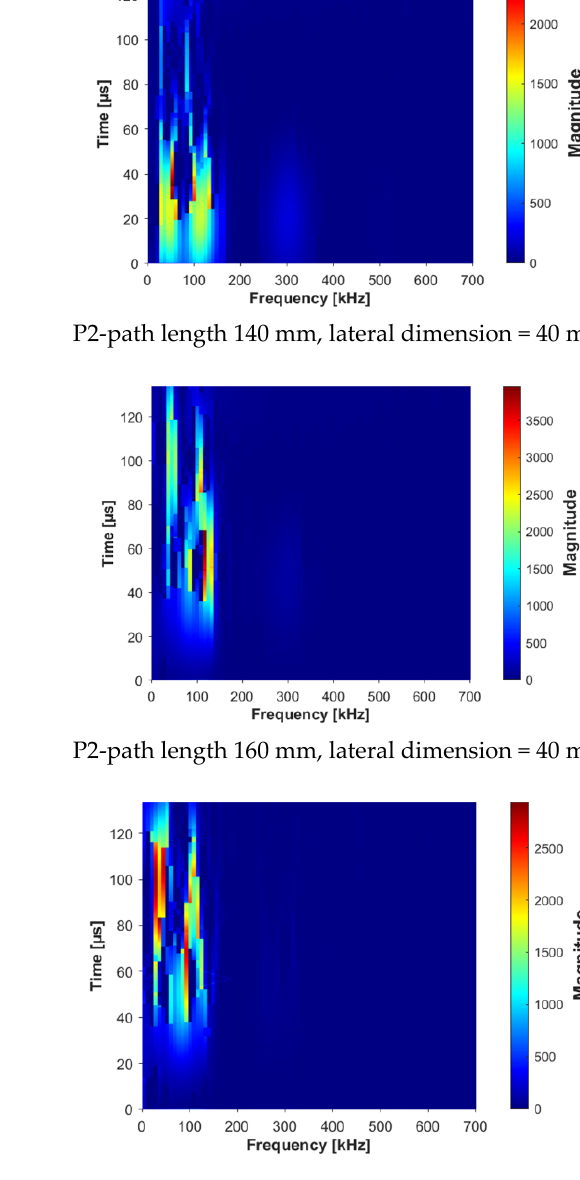
Figure 13. Spectrograms obtained by Fourier synchrosqueezing transform of signals registered after transmission through epoxy concrete samples with different shape and